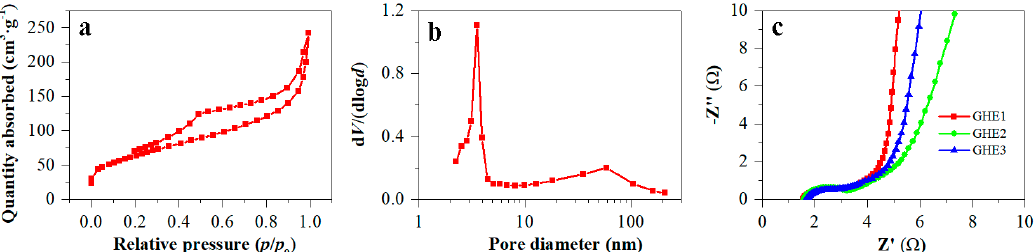
Figure 6. N 2 adsorption-desorption isotherm ( a ) and the corresponding BJH pore distribution plot ( b ) of GH, and Nyquist plots ( c ) for GHE-based supercapacitors.